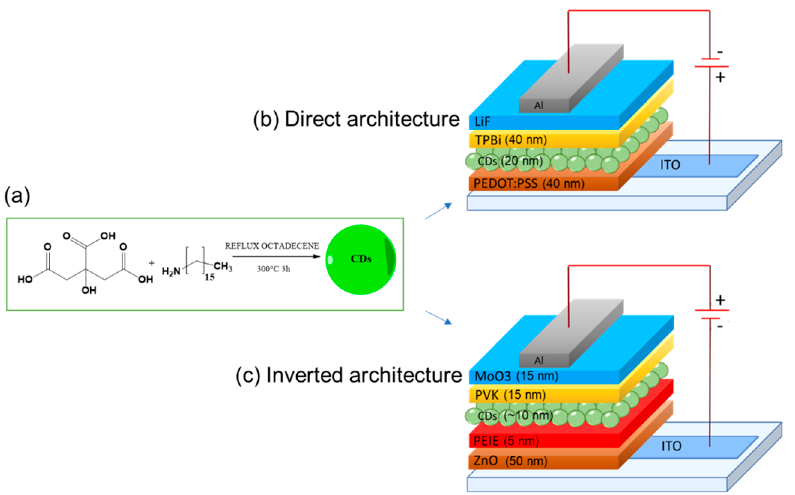
Figure 8. Schematic representation of ( a ) CD synthesis and typical devices architectures: ( b ) direct [74] and ( c ) inverted [73] in which CDs are incorporated as